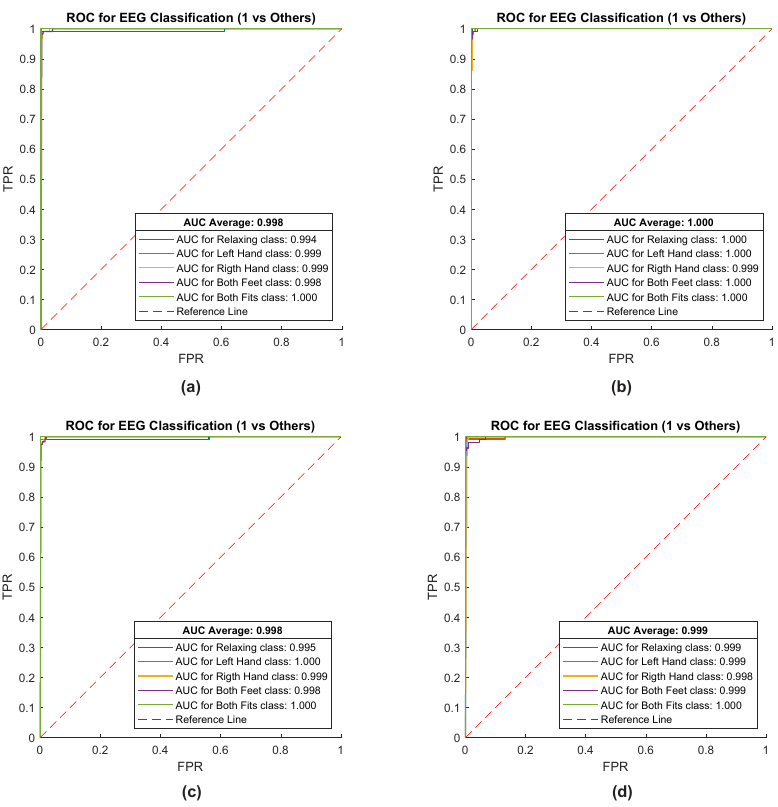
Figure 7. The receiver operating characteristic (ROC) curves of the four ANN algorithms trained for EEG signals classification, related to the movements of hands and feet: ( a ) ROC curves of the Narrow-ANN algorithm, ( b ) ROC curves of the Medium-ANN algorithm, ( c ) ROC curves of the Wide-ANN algorithm, and ( d ) ROC curves of the Bilayered-ANN algorithm.